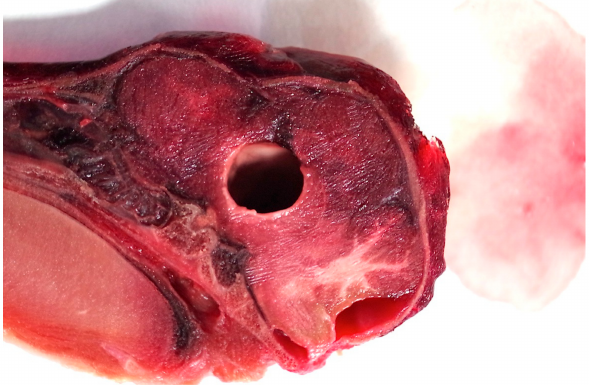
Figure 13. Neopallial cyst (proencephaly) within the brain of piglet 171 (sagittal